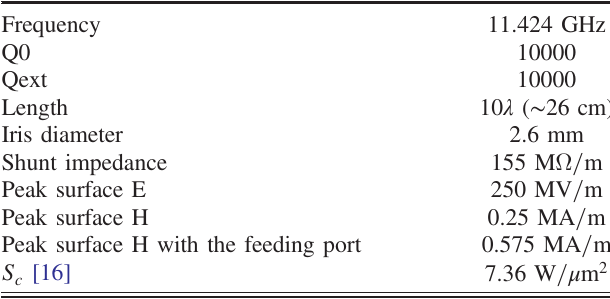
TABLE I. Summary of the cavity accelerating design param- eters. The peak fields are for an average gradient of 100 MV =